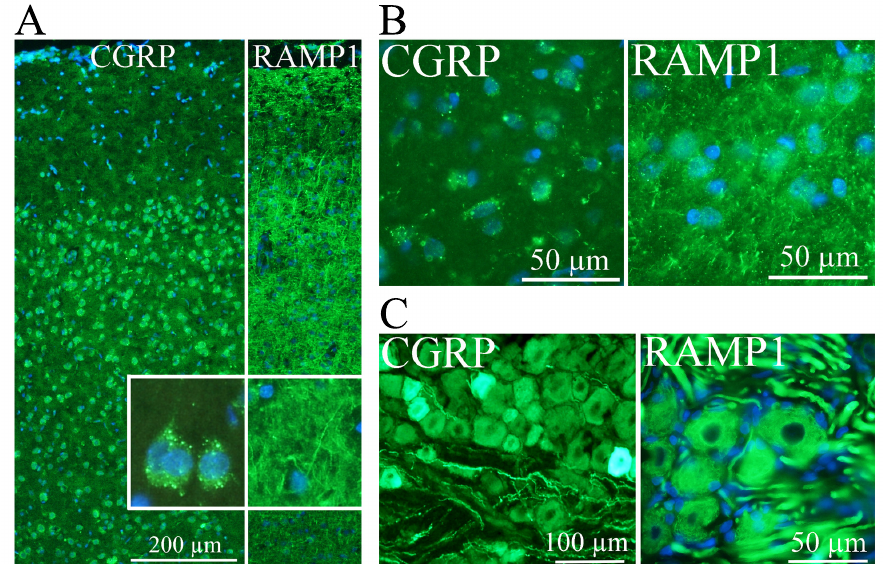
Figure 1. Calcitonin gene-related peptide (CGRP) and the CGRP receptor component receptor activity-modifying protein 1 (RAMP1) distribution using immunohistochemistry in rat brain, (modified from Warfvinge and Edvinsson, Cephalalgia 2019 [24]). Nuclei are stained blue with DAPI. In cortex ( A ), CGRP (left panel) is localized to neuronal cell bodies in cortical layers II-VI. Insert confirms the cytoplasmic location, and granular pattern of CGRP staining, as well as the lack of staining in neuronal processes. RAMP1 (right panel) was localized in processes and found to travel in all directions, horizontal, between layers or spanning through the entire gray matter. In the paraventricular hypothalamic nucleus ( B ), the distribution of CGRP and RAMP1 was similar; CGRP being localized to the cytoplasm of neurons, while RAMP1 was present in cellular processes. In the trigeminal ganglion ( C ), both CGRP and RAMP1 are observed in cell bodies. CGRP was localized to small and medium-sized neurons, and to thin neuronal processes. RAMP1, in contrast, was observed in larger neurons and thicker